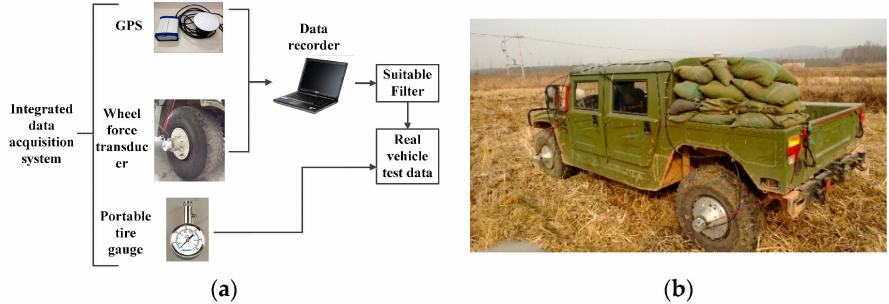
Figure 1. ( a ) Integrated data acquisition system; ( b ) Instrumented test vehicle.